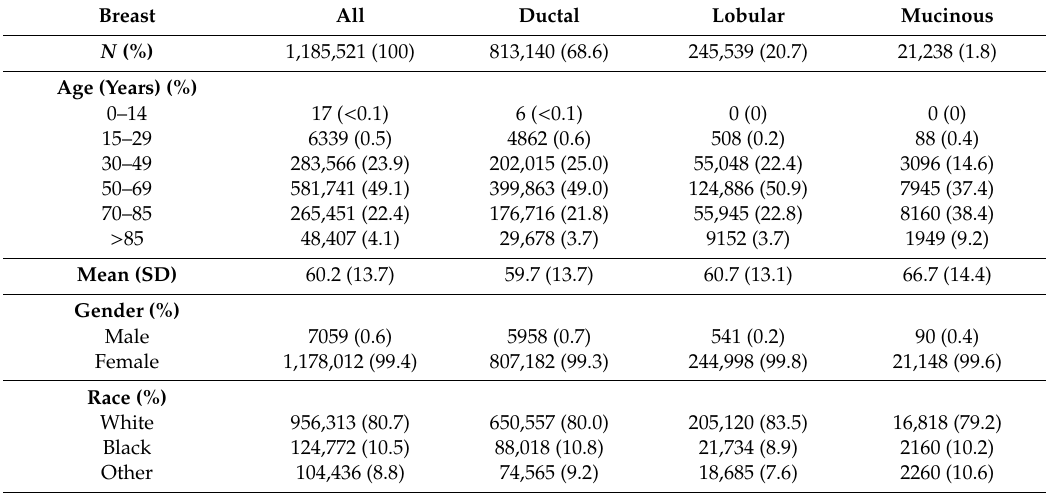
Table 3. Baseline demographics and clinical characteristics by histology for breast